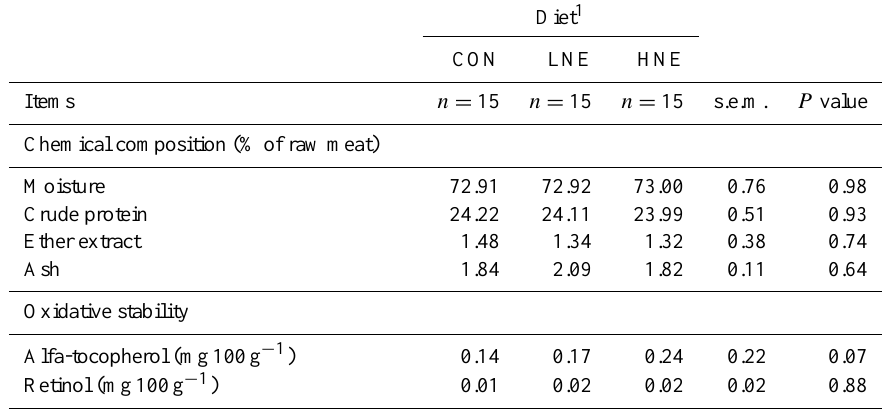
Table 4. Effect of Lippia citriodora extract on chemical composition and oxidative stability of meat in New Zealand white